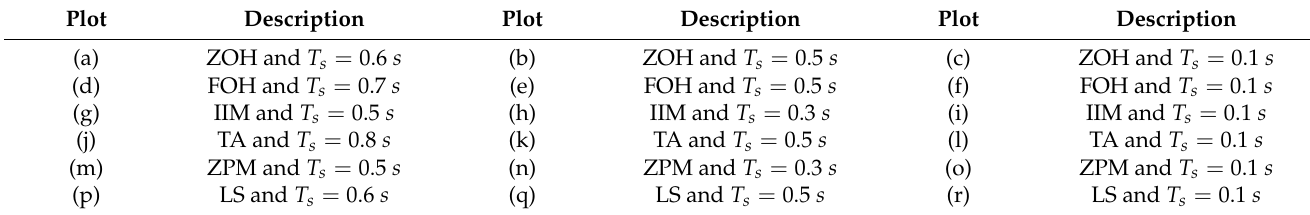
Table 1. Discretization method and sample time used for each plot displayed in Figure 6.